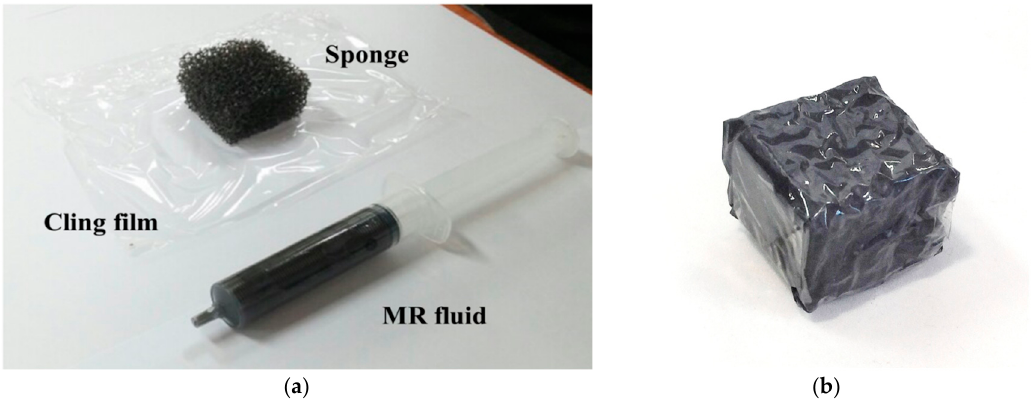
Figure 7. MR sponge tactile device; ( a ) components; ( b ) assembly.